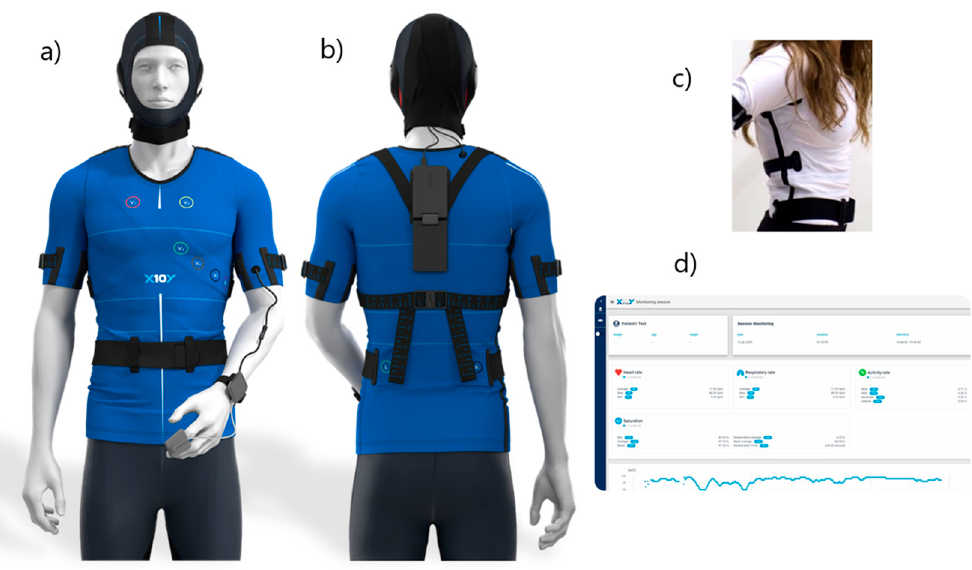
Figure 4. ( a ) Front and ( b ) back views of L.I.F.E.’s medical compression garment (BWell). The back view (right) shows where the plug is placed when the garment is worn. Both views show a cap to perform EEG which is currently being developed by the company. ( c ) An example of BWell’s fitting when worn. ( d ) Real-time data visualization dashboard. The figure was adapted from the website of the company producing the garment [106].